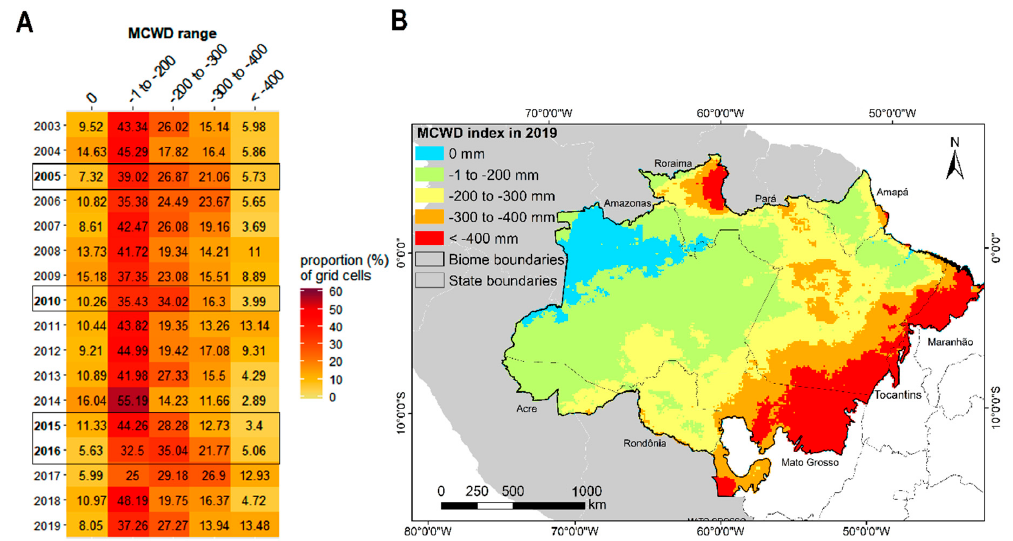
Figure 1. ( A ) For each year, the proportion of grid cells with Maximum Cumulative Water Deficit (MCWD) values within each of the five intervals. Years with extreme droughts in the Amazon are highlighted in boxes. ( B ) The spatial distribution of MCWD values in 2019 across five different intervals.